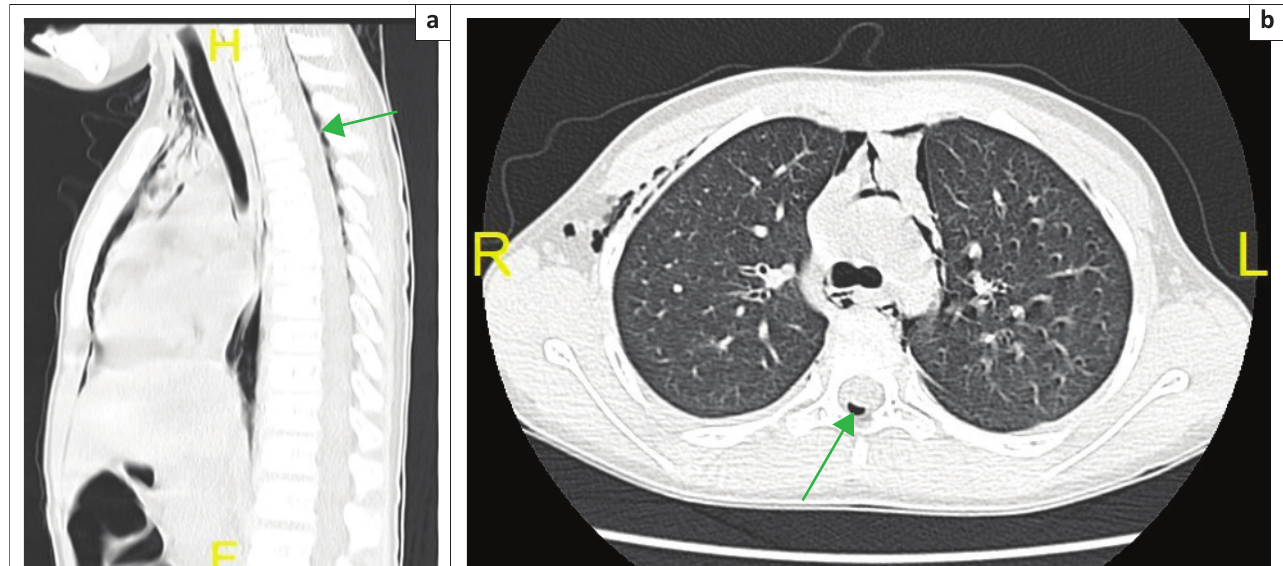
FIGURE 3: (a and b) Sagittal reconstructed image through the thoracic spine and axial image at level of carina, lung settings, demonstrating epidural emphysema (green arrow).